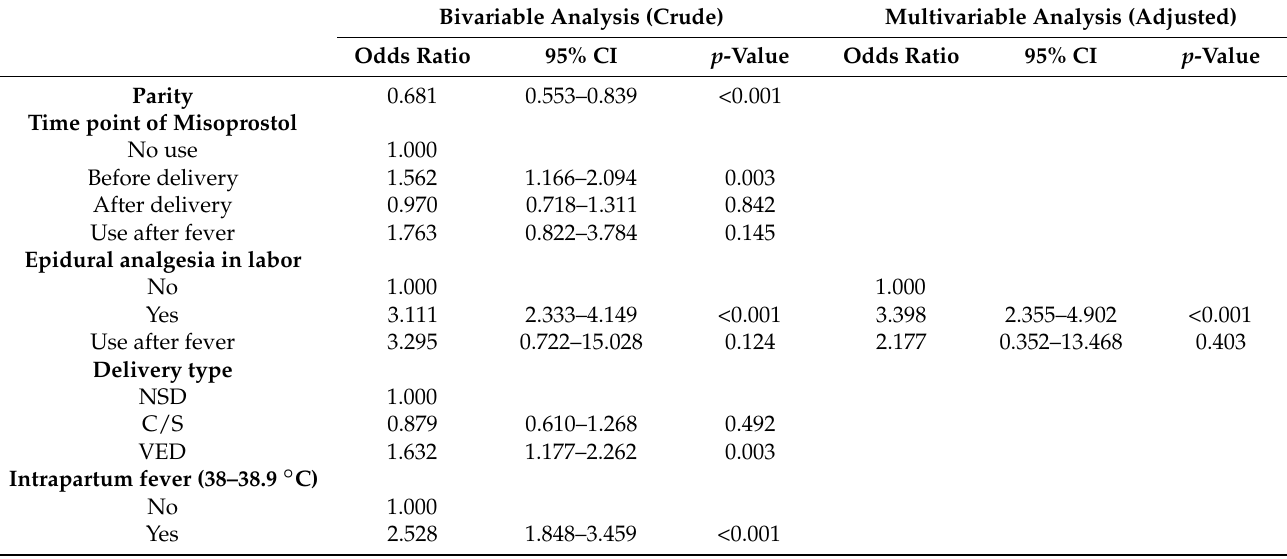
Table 4. Logistic regression analysis of probable or proven neonatal sepsis. Bivariable Analysis